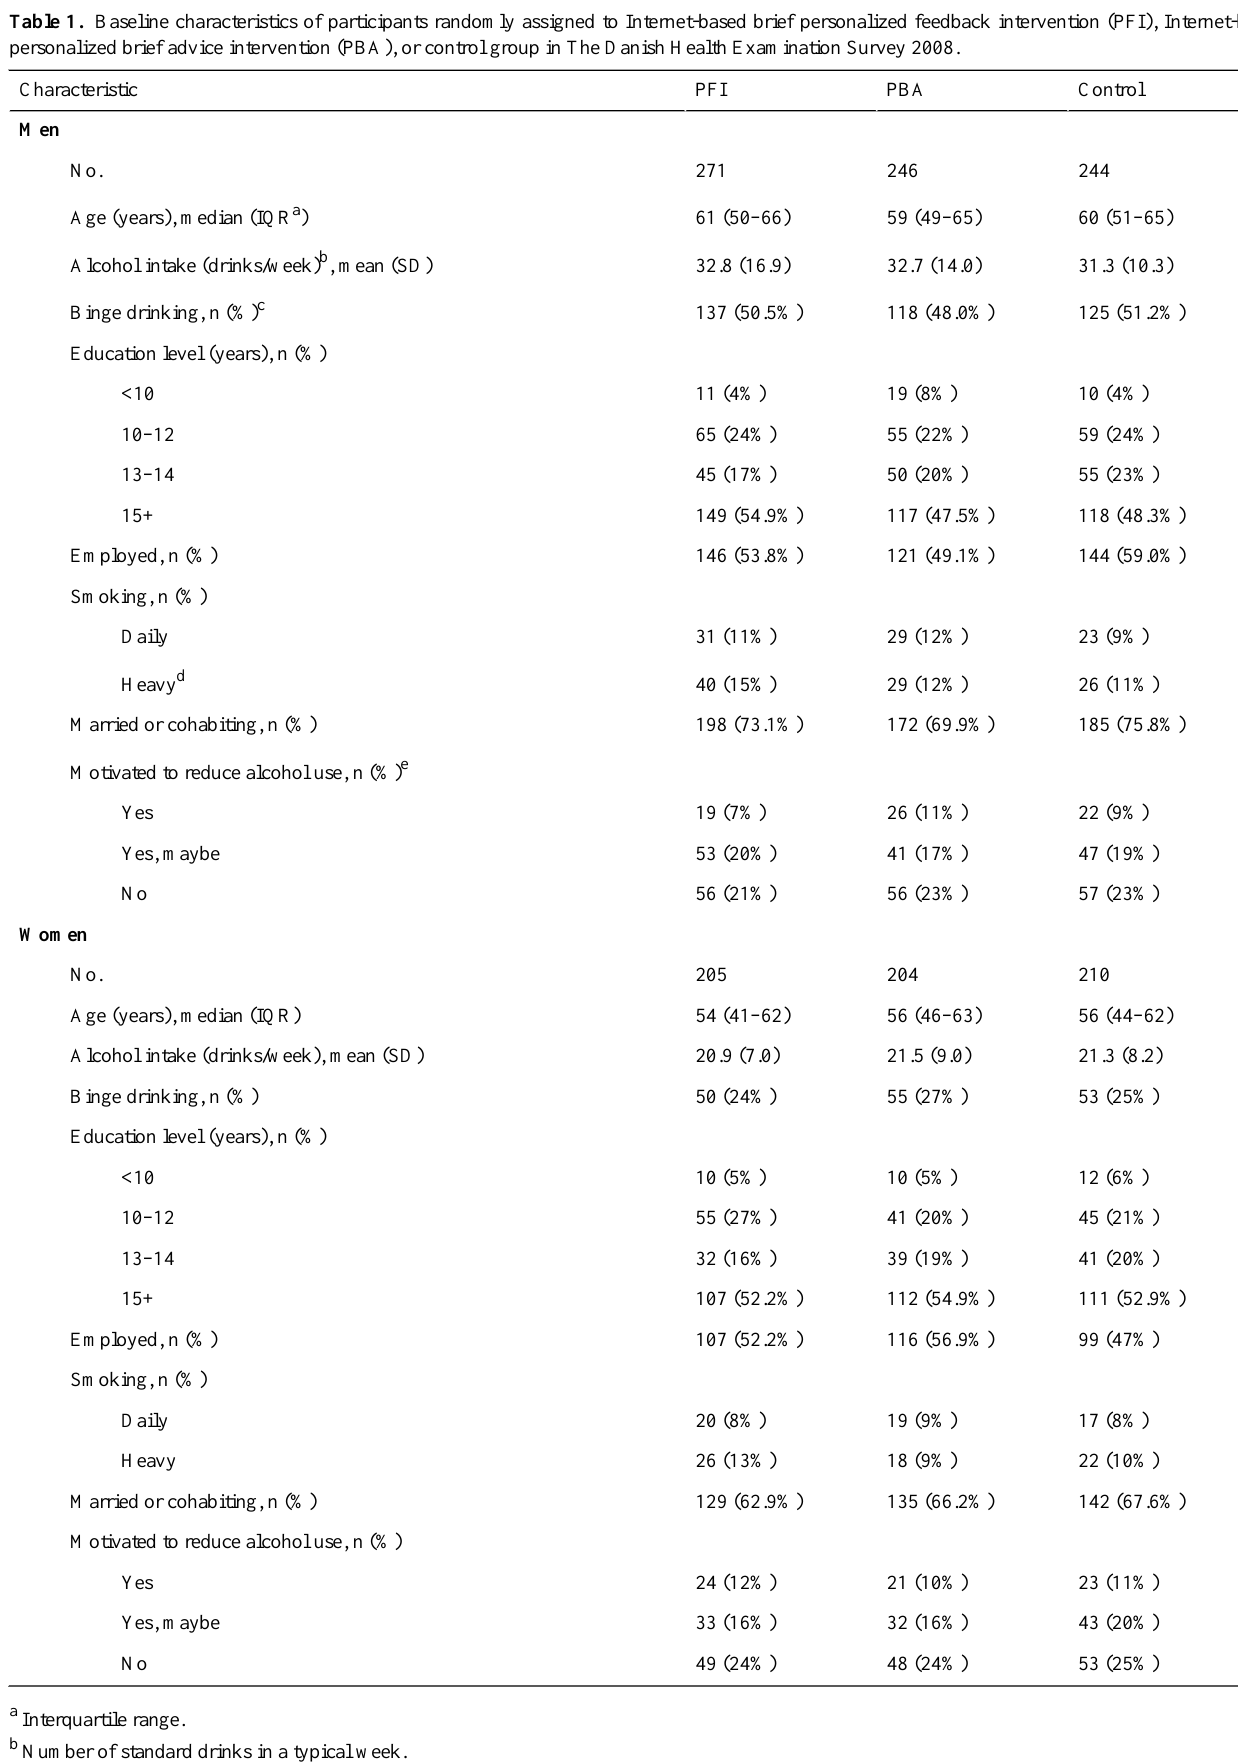
Table 1. Baseline characteristics of participants randomly assigned to Internet-based brief personalized feedback intervention (PFI), Internet-based personalized brief advice intervention (PBA), or control group in The Danish Health Examination Survey